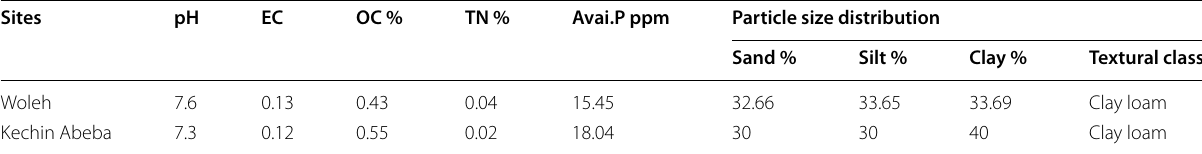
Table 1 Soil sample result before planting